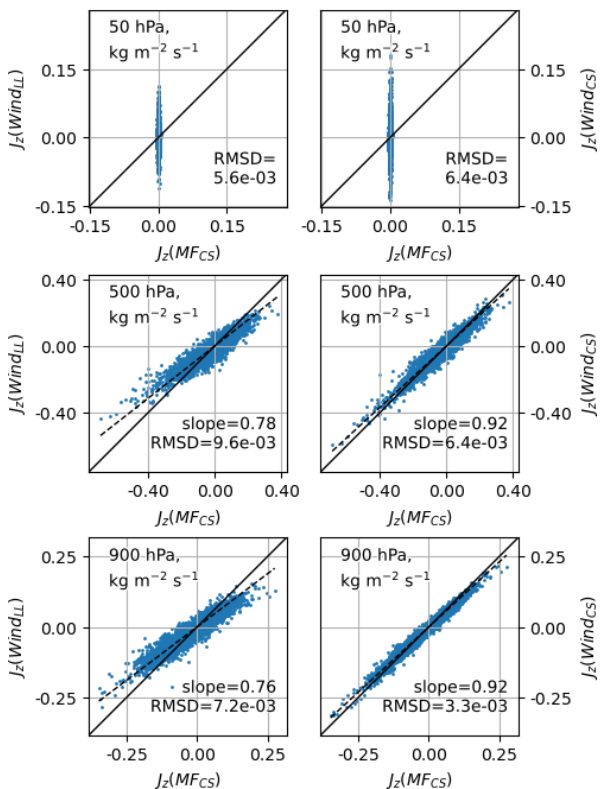
Figure 4. Comparison of vertical mass flux calculations at 50, 500, and 900hPa in the global GCHP domain using different in- put fields for a 5min time step at an example time (1 March 2017 12:30:00UTC). Each point represents a grid cell at the correspond- ing pressure. J z ( MF CS ) is the vertical mass flux using native C180 C-grid mass fluxes. J z ( Wind CS ) is the vertical mass flux using C180 A-grid winds. J z ( Wind LL ) is the vertical mass flux calculated using 0.5 ◦ × 0.625 ◦ A-grid winds. Note the different scales for the differ- ent rows of